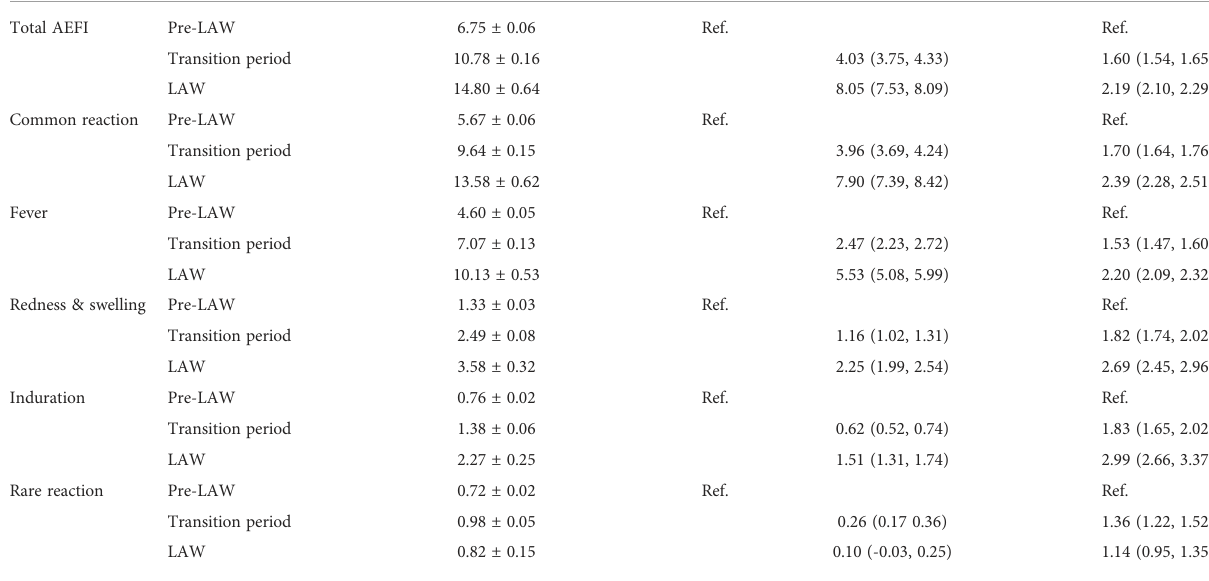
TABLE 3 Average rate of AEs following HepB of different stages of LAW conduction from 2013 to 2020 (per 100 thousand doses). Adverse